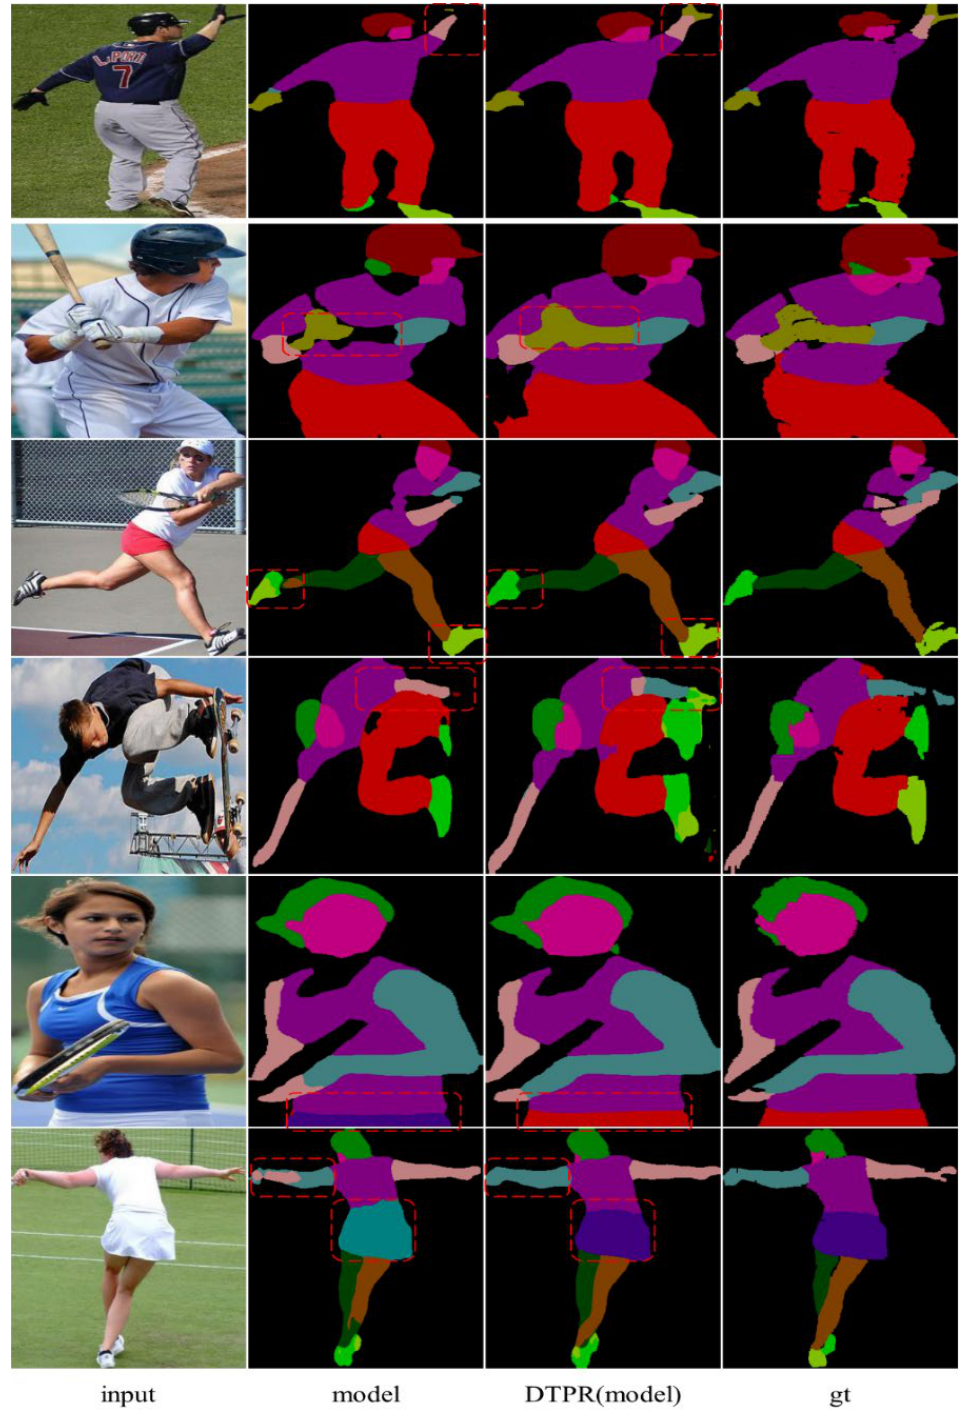
Figure 8. Visual comparison of human parsing results on the LIP validation set.